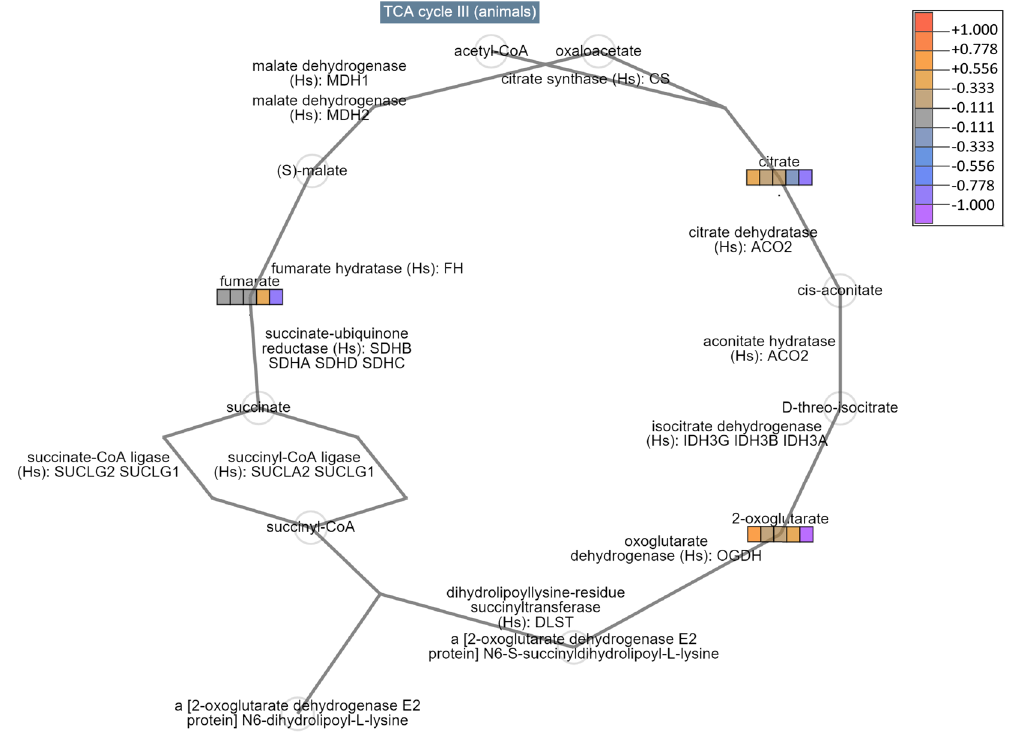
Figure 4. Schematic representation of key intermediates and enzymes involved in the tricarboxylic acid (TCA) cycle. The relative concentration of three key metabolites (citrate, α -ketoglutarate [2-oxoglutarate] and fumarate) is illustrated with the coloured boxes, representing the respective frog sample groups from left to right: (i) negative controls, (ii) 4 days post exposure (DPE), (iii) 8 DPE, (iv) 14 DPE, and (v)